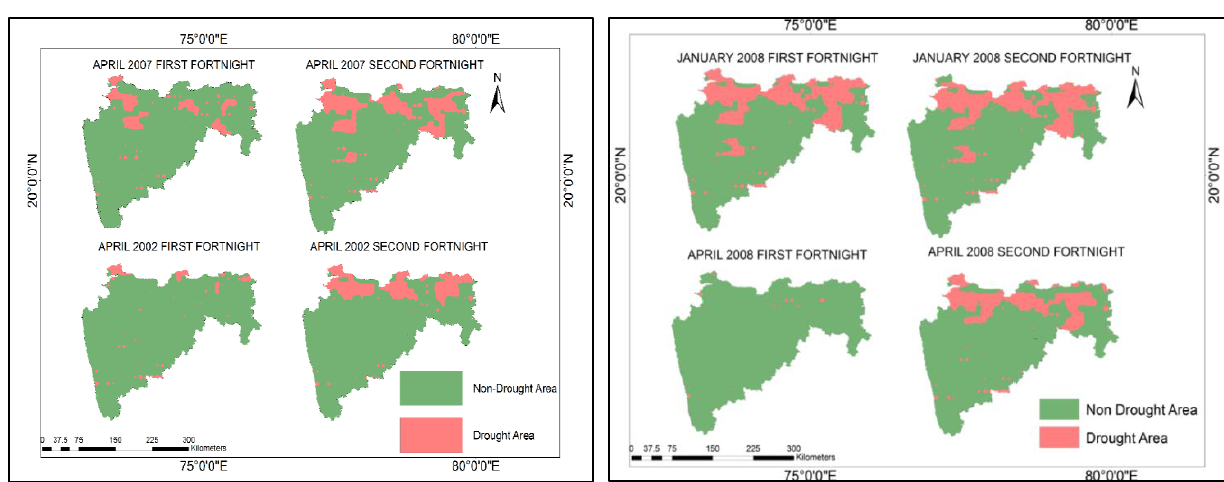
Figure 10 (a).Interpolated EDI maps for the year 2007 and 2002 (b)Interpolated EDI map for the year